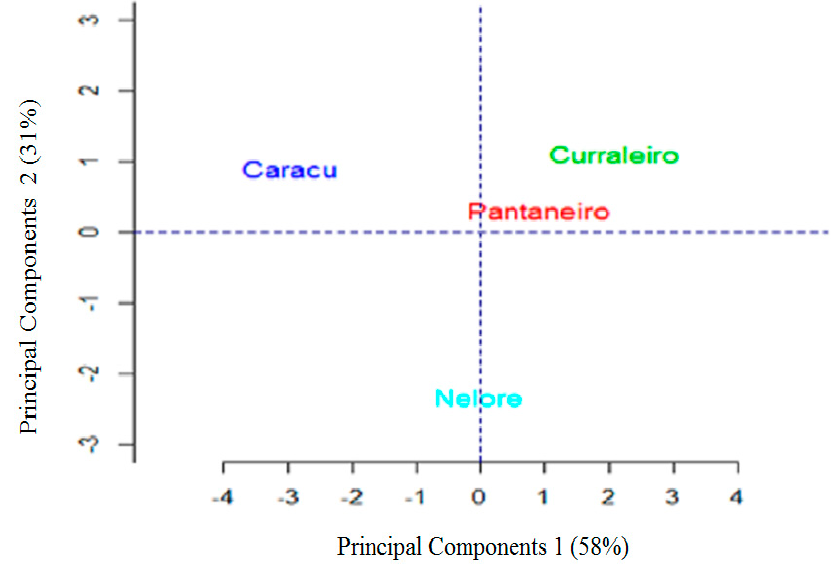
Figure 3. Graphic dispersion of the first two principal components to observe the differences between the breeds (Caracu, Curraleiro Pé-Duro, Bovino Pantaneiro, and Nelore).